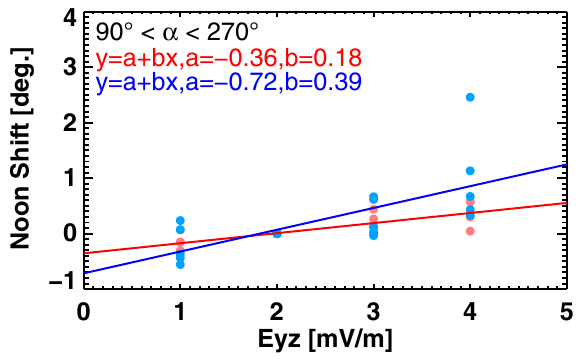
Fig. 7. Dependence of the noon-midnight shift of the large-scale Birkeland current distribution on solar wind electric field, E yz , for the IMF clock angle range 90 ◦ < α < 270 ◦ . The Iridium observa- tions and the BATS-R-US plus RCM simulations are represented by blue and red dots, respectively. The lines of the respective color rep- resent the linear least-squares fit functions noted at the top of each